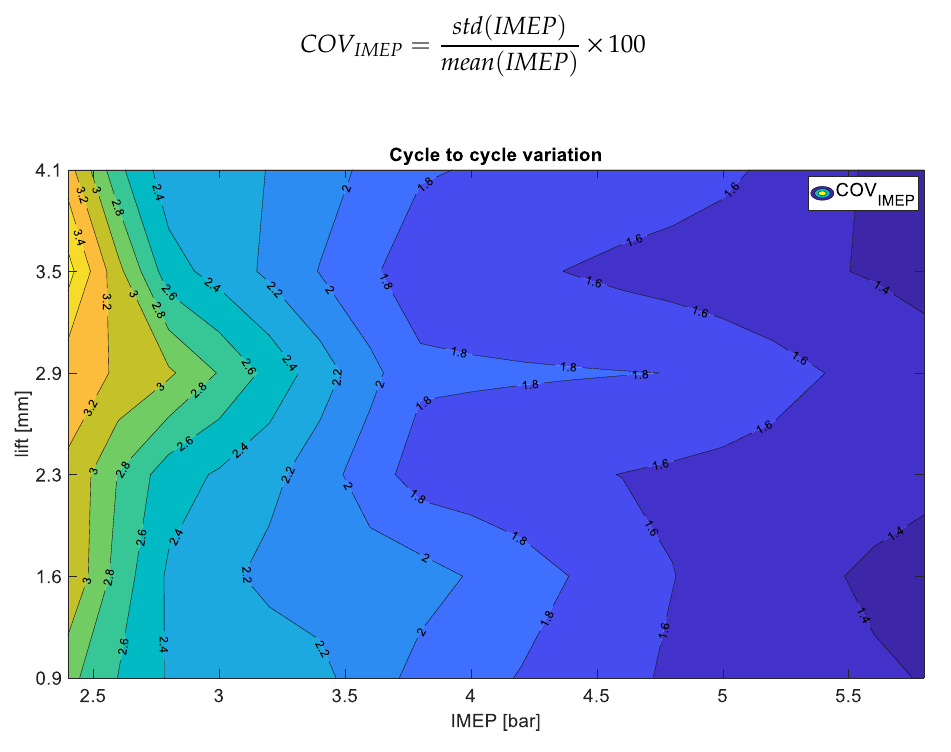
Figure 6. Cycle to cycle variation .